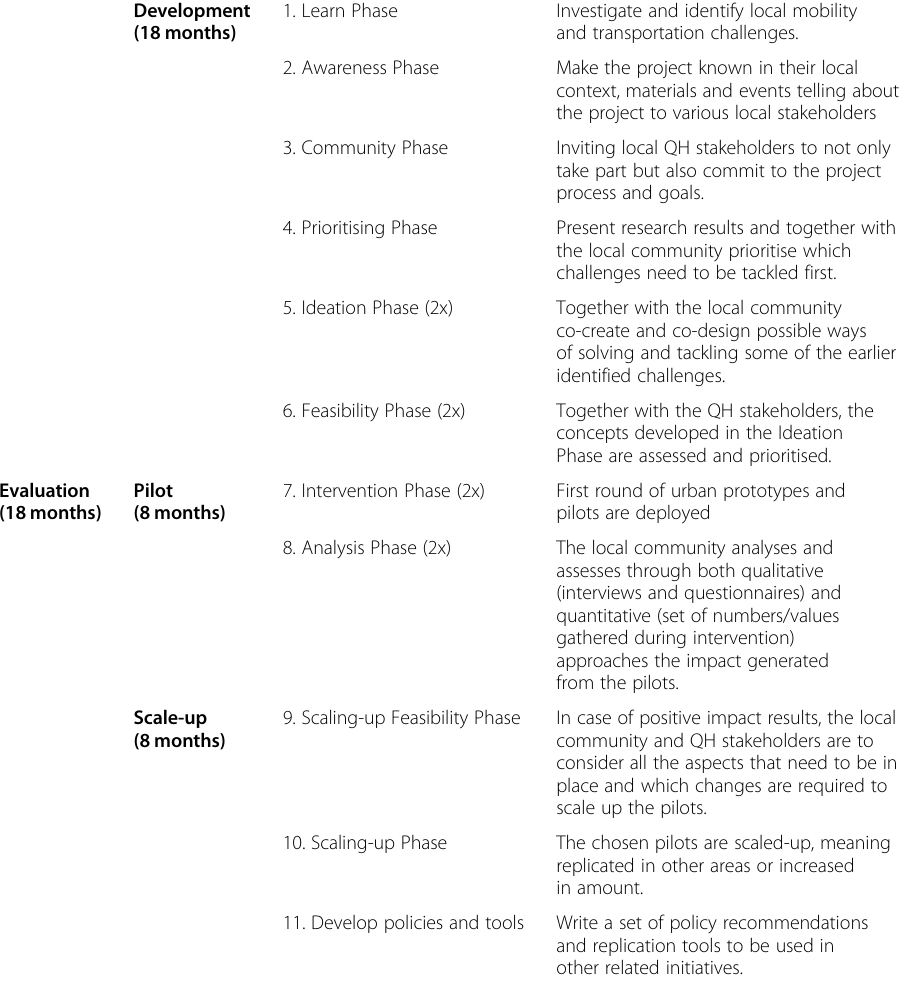
Table 3 Suggested definitions for the Cities-4-People process